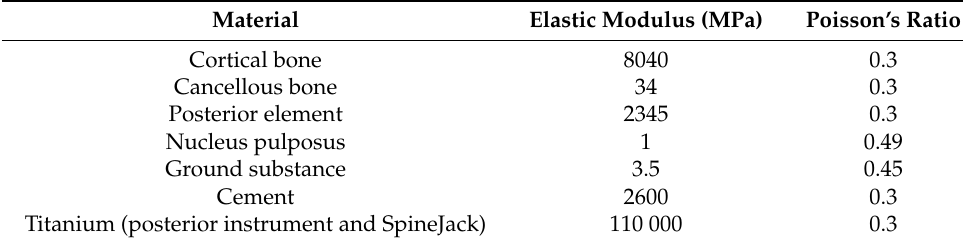
Table 2. The material properties used in the